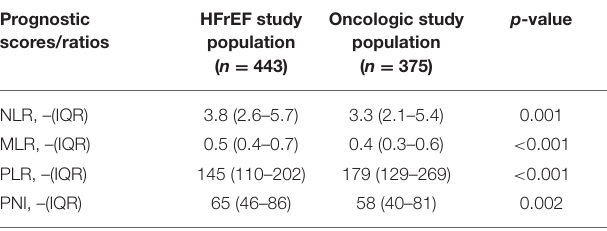
TABLE 2 | Prognostic scores in HFrEF vs.